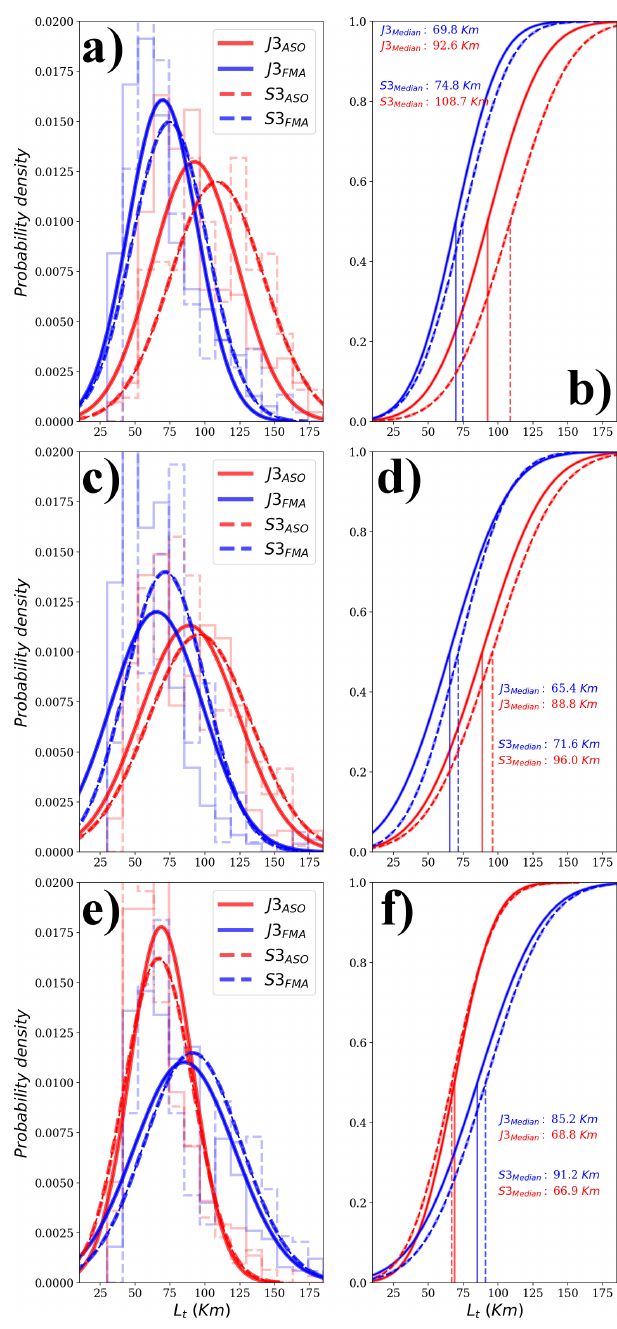
Figure B3. Histogram and cumulative distribution function for the values of the intercept wavelength observed during August– September–October (ASO) and February–March–April (FMA) for Jason-3 (full line) and Sentinel-3 (dashed line) over three re- gions: (a, b) northwestern Pacific (20–45 ◦ N; 135–170 ◦ E), (c, d) northwestern Atlantic (25–45 ◦ N; 280–320 ◦ E), and southwest- ern Atlantic (55–25 ◦ S; 290–320 ◦ E). Only the pixels with seasonal differences significant at 95% confidence were